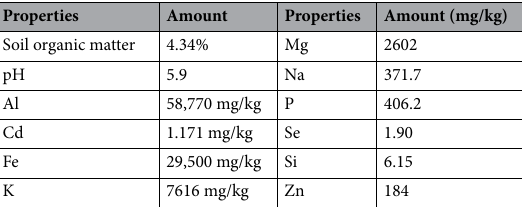
Table 1. Chemical characterization of red soil. The detected elements were